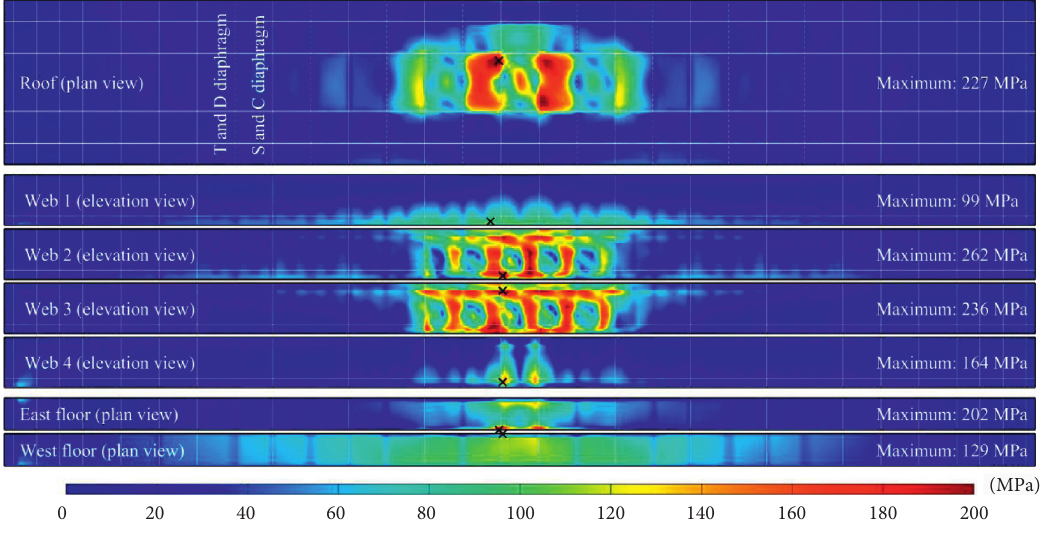
Figure 11: Mises stress of main plates at